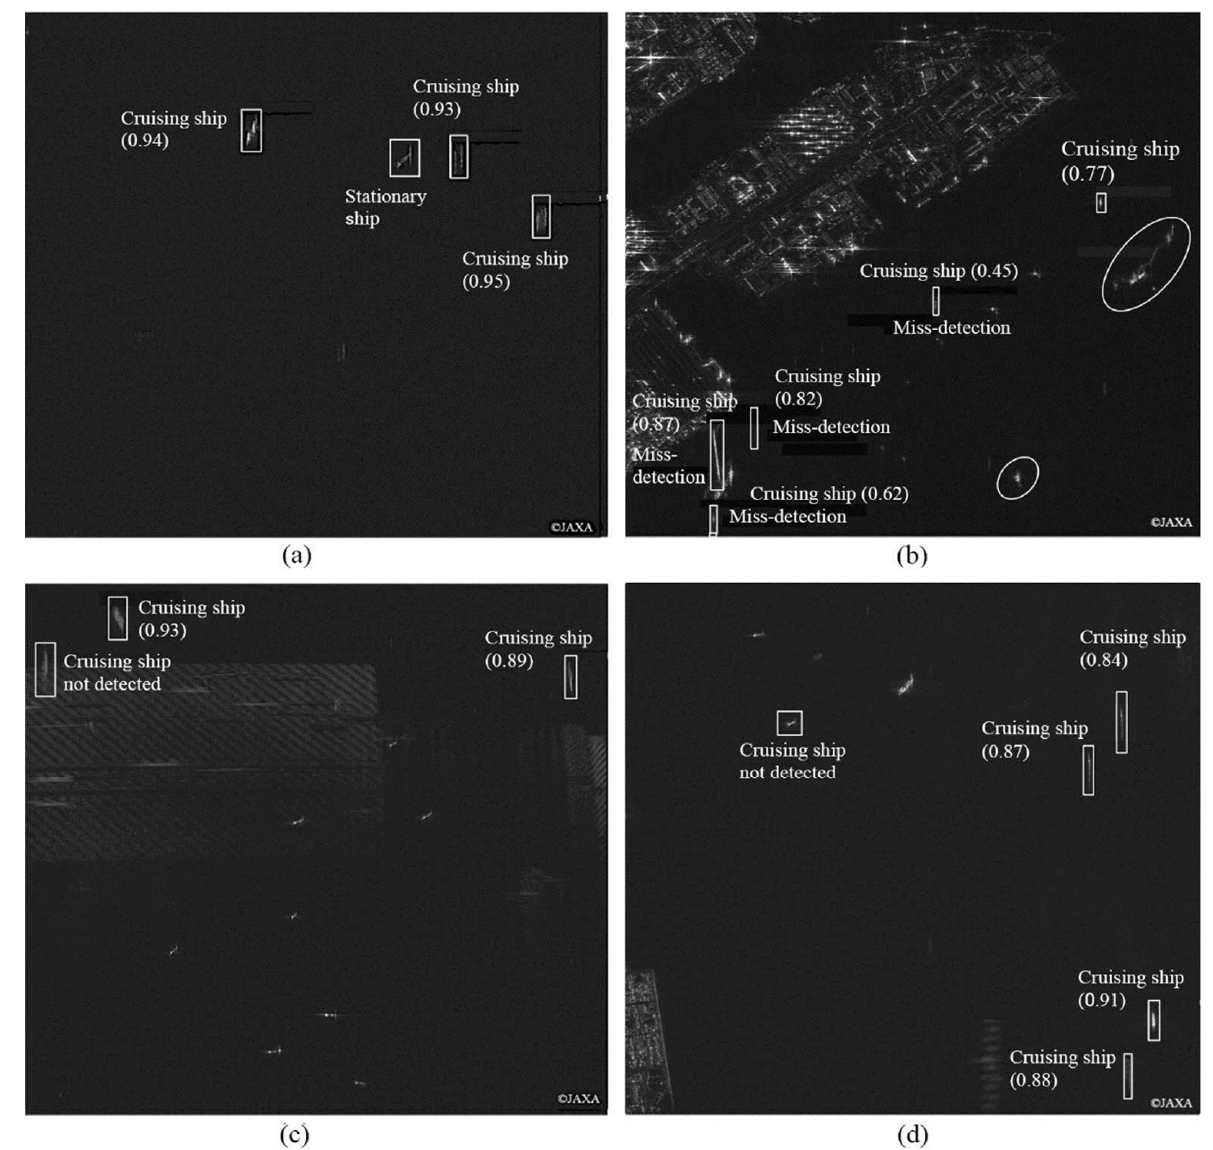
Figure 5. Examples of successful and misdetection results in the test images that were not used in the training and validation processes. The azimuth and range directions are from top to bottom and right to left, respectively. ( a ) Successful results for detecting moving ships. The numbers in brackets are the confidence score. ( b ) Results of detection and misdetection. The model could avoid the misdetection of ghost images in the white ellipses, while parts of breakwaters were incorrectly detected. ( c ) Two detected cruising ships and an undetected image over the Radio Frequency Interference (RFI). ( d ) Four detected cruising ships on the right-hand while a ship cruising in the range direction is not detected (image size is approximately 8000 × 7850 pixels). Table 2. Detection results using the test images confirmed by AIS data. TP and FP are the numbers of correctly detected moving ships and misdetected ships, respectively. FN is the number of moving ships but not detected, and non-AIS is that of detected ships without AIS data.